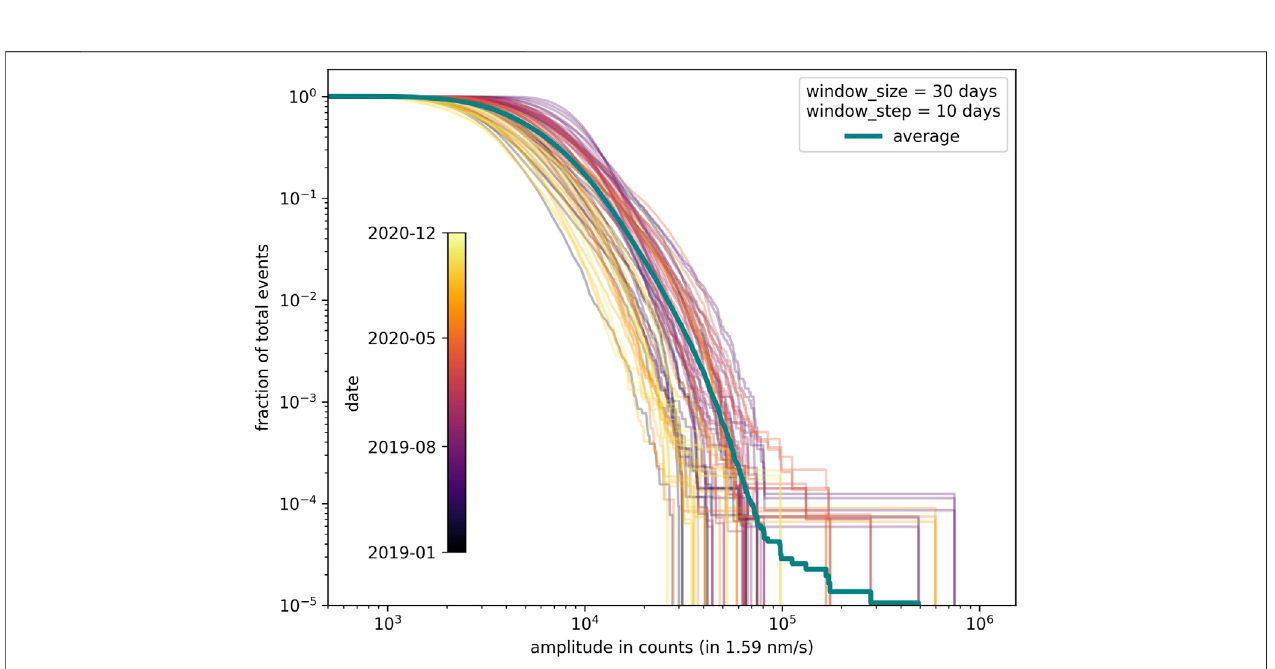
FIGURE 10 | The amplitude-frequency relation and its temporal development over a period of 2 years (2019 – 2020) at Stromboli. The catalog contains more than 290.000 seismo-volcanic events for this time period. The window size used to compute the individual curves is 30 days; a window step size of 10 days was used.